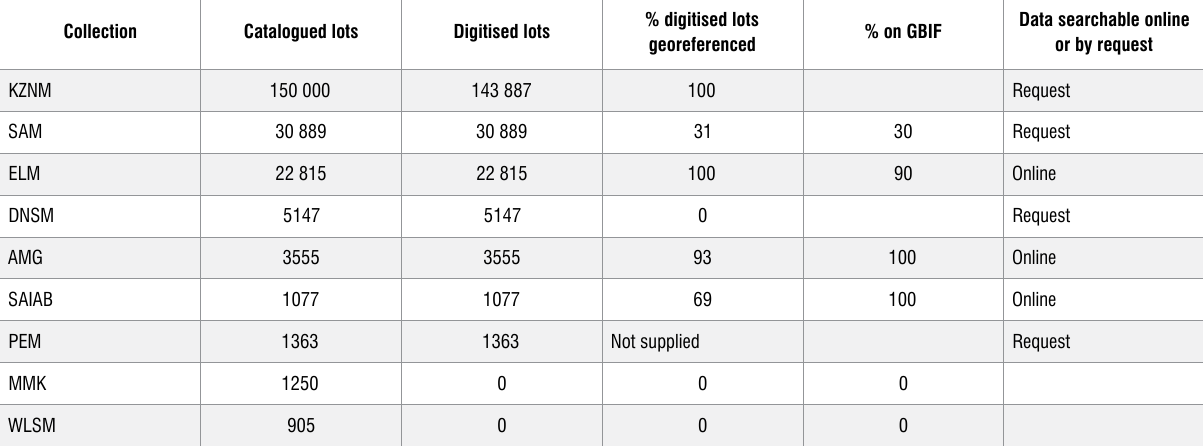
Table 6: Digitisation and data accessibility of mollusc collections (lots)